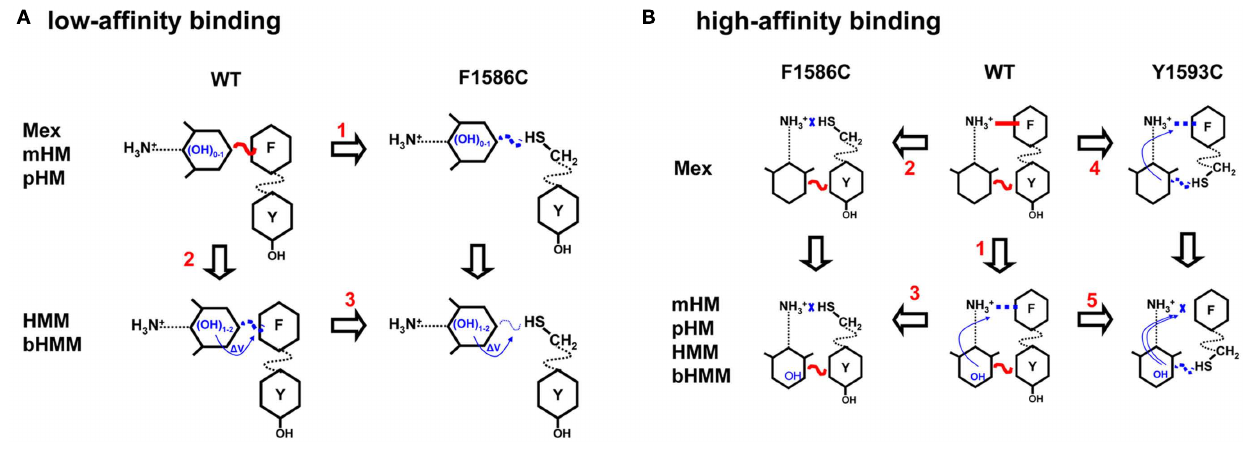
FIGURE 9 | Synopsis of possible interactions of mexiletine and hydroxylated analogs with the low (A) and high (B) binding site within the wild-type hNav1.4 channel and its mutants F1586C and Y1593C. (A) Regarding the low-affinity binding to closed channels, our results are in accord with an horizontal orientation of the drug, with the aryloxy moiety interacting either directly or indirectly with F1586 through electrostatic coupling.The addition of OH groups as in mHM and pHM does not modify aryloxy electrostatic potential thereby leaving this interaction unaltered.The F1586C mutation weakens interaction with Mex, mHM, and pHM to the same extent (arrow 1). Introduction of OH as in HMM and bHMM weakens the interaction due to modification of aryloxy electrostatic potential and possibly other